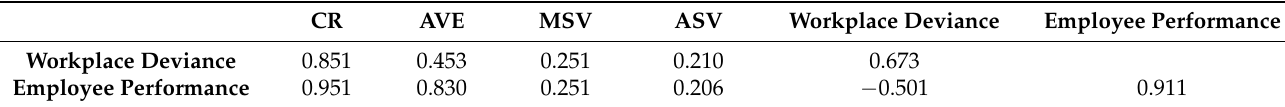
Table 4. Convergent and discriminant validity and construct